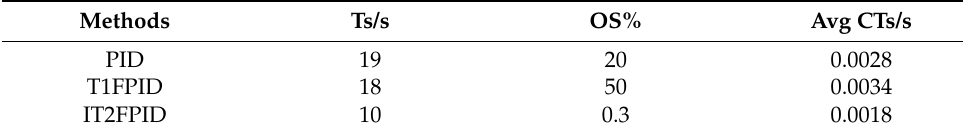
Table 7. Performance index results, without noise perturbations.